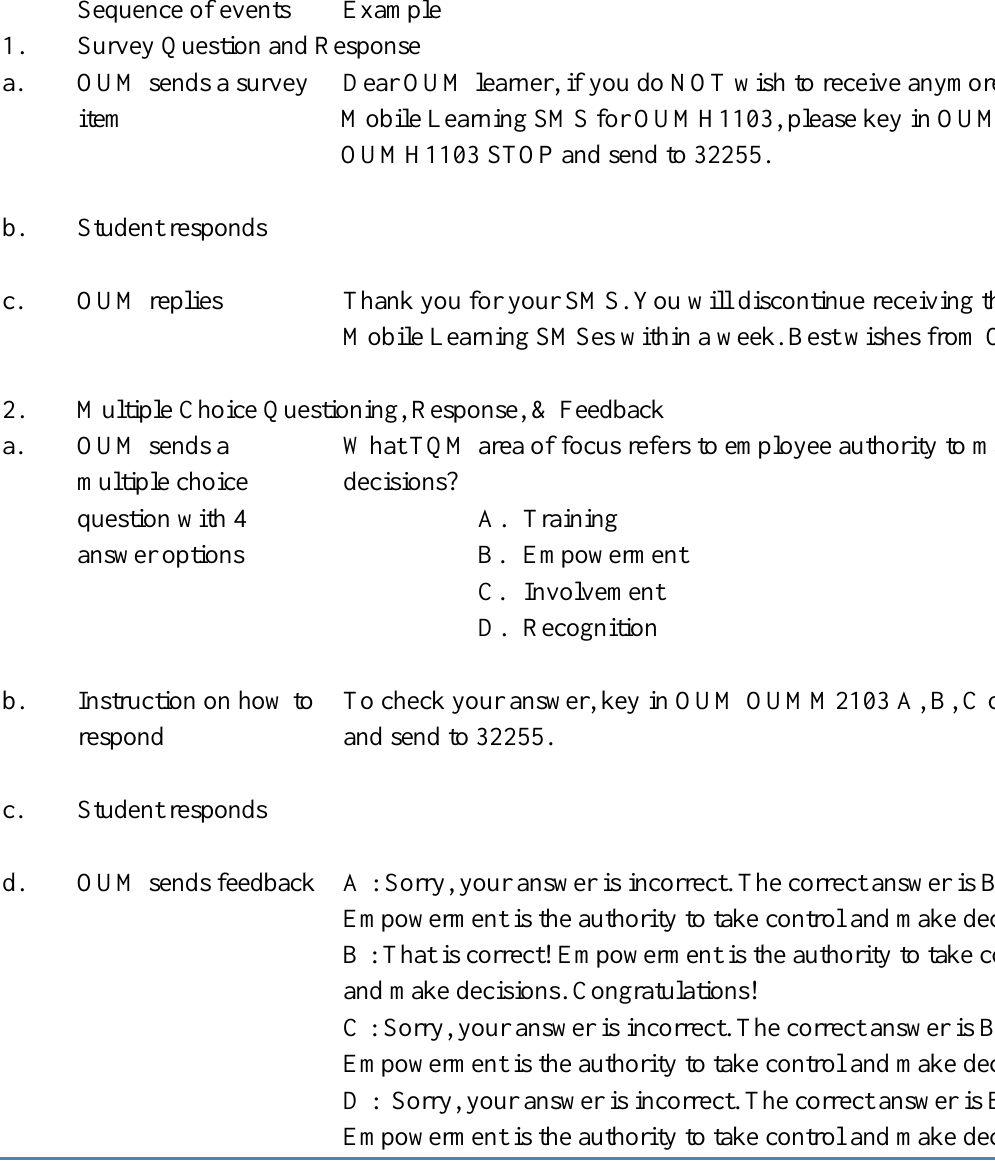
Table 2 Interactive SMS